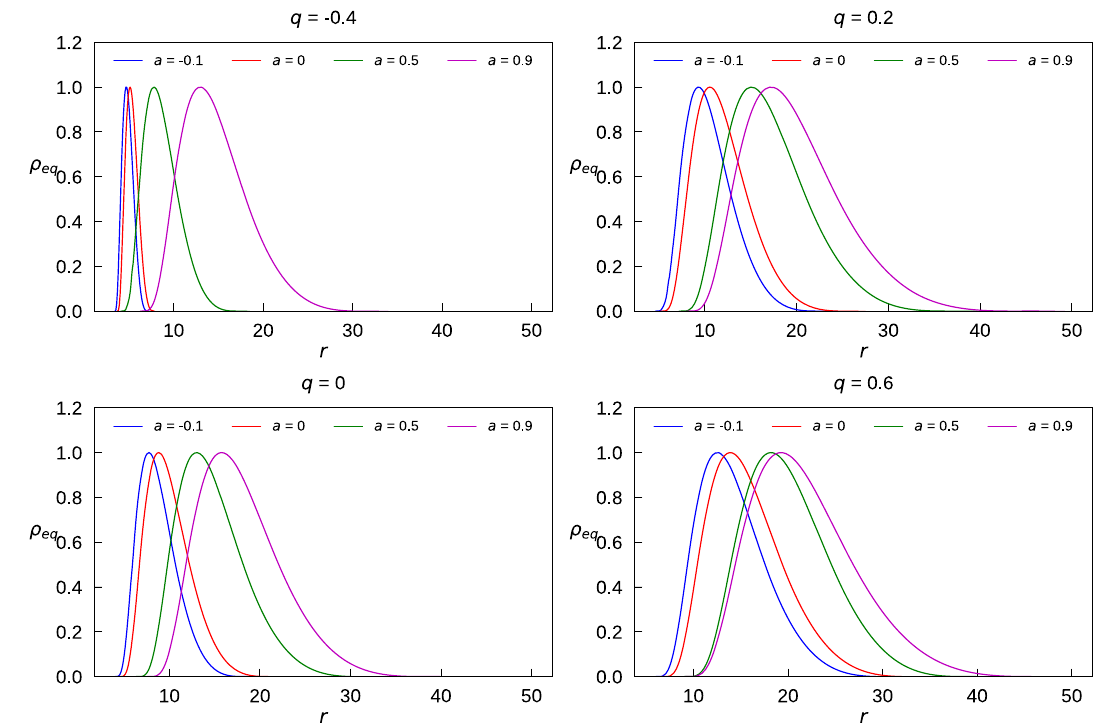
Fig. 9 Density profile on the equatorial plane for different values of parameters q and a . The plots are scaled at each case by the value at the